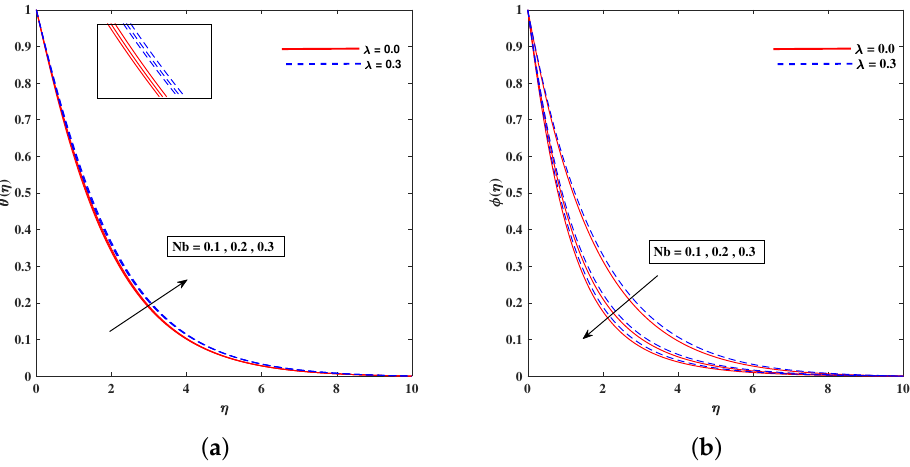
Figure 9. Fluctuation of Nb on temperature θ ( η ) ( a ) and concentration profile phi ( η ) ( b ).